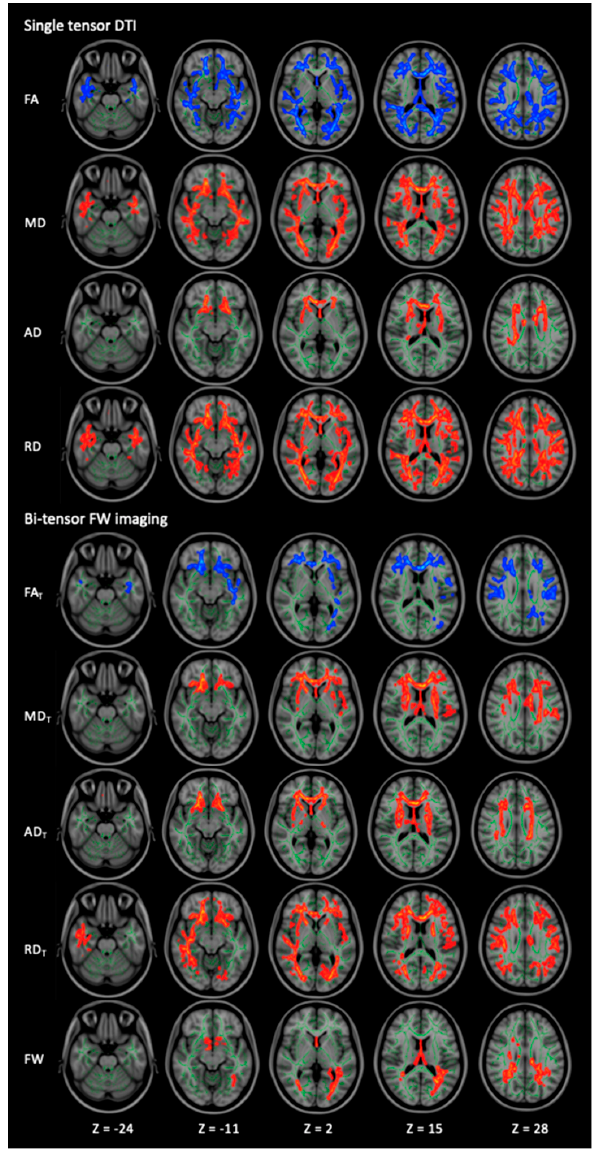
Figure 1. Comparison of DTI (FA, MD, AD, and RD) and FW imaging (FA T , MD T , AD T , RD T , and FW) indices between healthy controls and patients with PD. TBSS analyses show that patients with PD have significantly ( p < 0.05, FWE-corrected) lower FA and FA T (blue/light-blue voxels) and significantly higher MD, MD T , AD, AD T , RD, RD T , and FW (red-yellow voxels) compared with healthy controls. The skeleton is presented in green. To aid visualization, the results are thickened using the fill script implemented in the FMRIB Software Library. AD, axial diffusivity; AD T , free water-corrected axial diffusivity; DTI: diffusion tensor imaging; FA, fractional anisotropy; FA T , free water-corrected fractional anisotropy; FW, free water; MD, mean diffusivity; MD T , free water-corrected mean diffusivity; PD, Parkinson’s disease; RD, radial diffusivity; RD T , free water-corrected radial diffusivity; TBSS, tract-based spatial statistics.